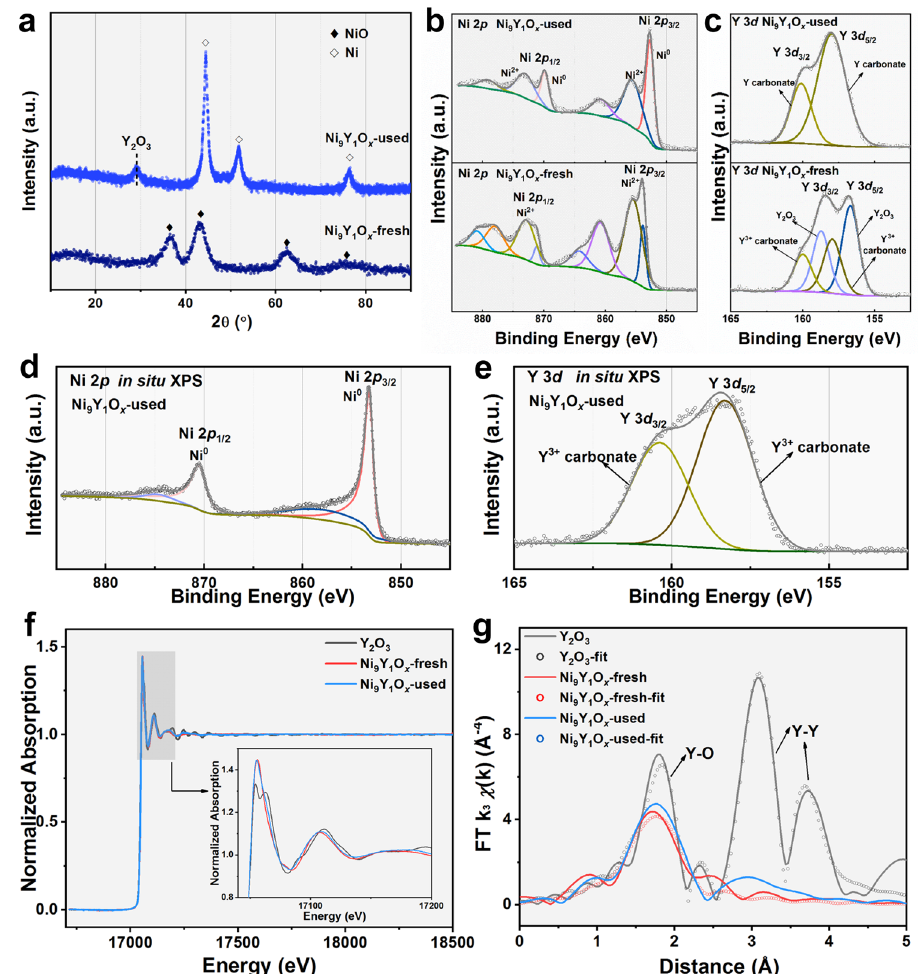
Fig. 3 Phase change and surface electronic structure. a XRD patterns of the fresh and used Ni 9 Y 1 O x catalysts; b , c XPS results of the fresh and used Ni 9 Y 1 O x catalysts; d , e quasi in situ XPS results of Ni 9 Y 1 O x -used; f Y K edge X-ray absorption near edge spectra pro fi les and g Y K edge EXAFS of the fresh and used Ni 9 Y 1 O x catalysts for experiment data (solid) and fi tted lines